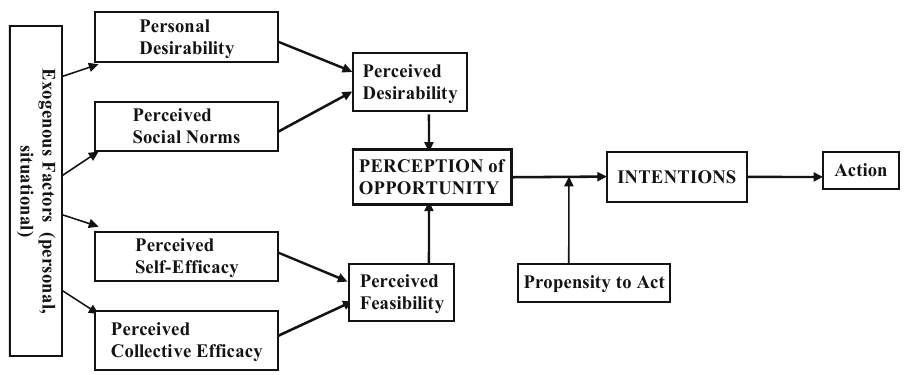
Figure 1. Intentions model (Krueger 2009, p. 58).